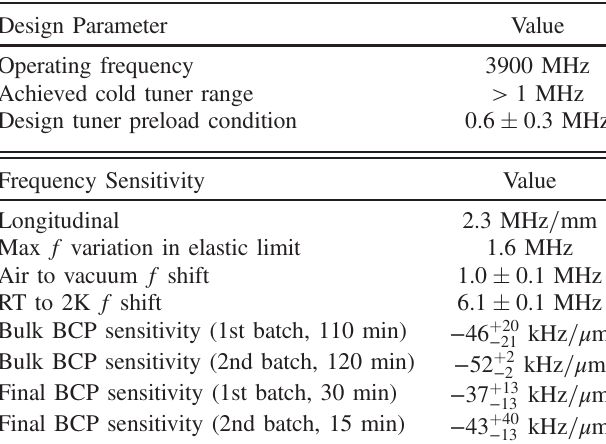
TABLE IV. Main cavity operational parameters and frequency ( f ) sensitivity coefficients. The uncertainties are expressed as the maximum spread of the measured